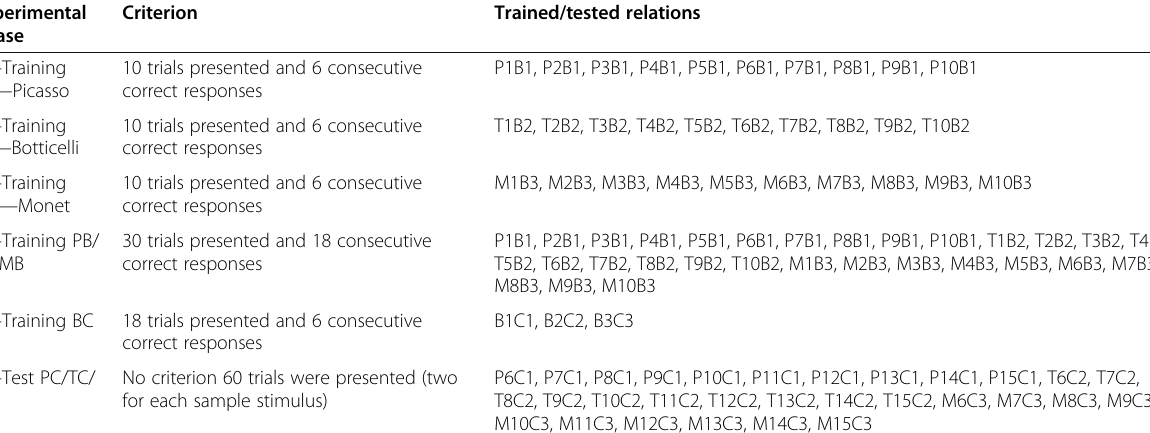
Table 2 Phases of experiment Experimental phase